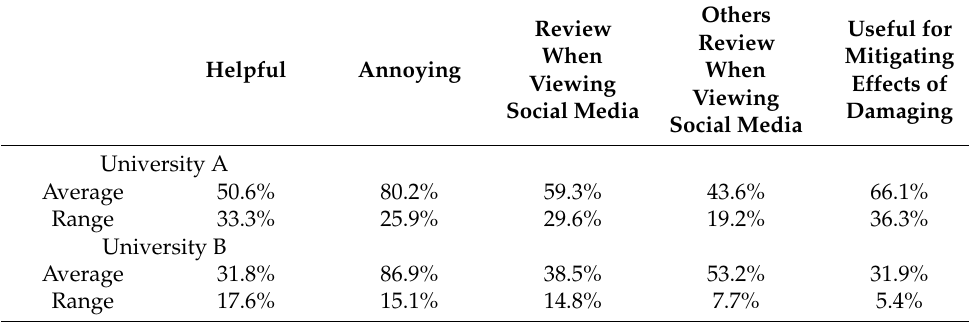
Table 20. Data characteristics—blocking label survey by school.